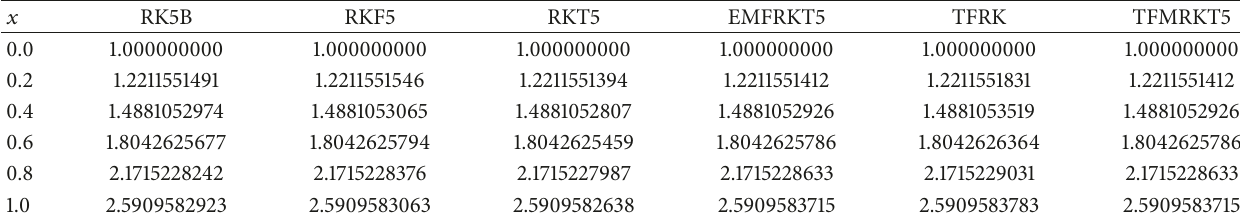
Table 4: Numerical results for problem in thin film flow (58) taking ℎ = 0.1 and 𝑘 = 3 .